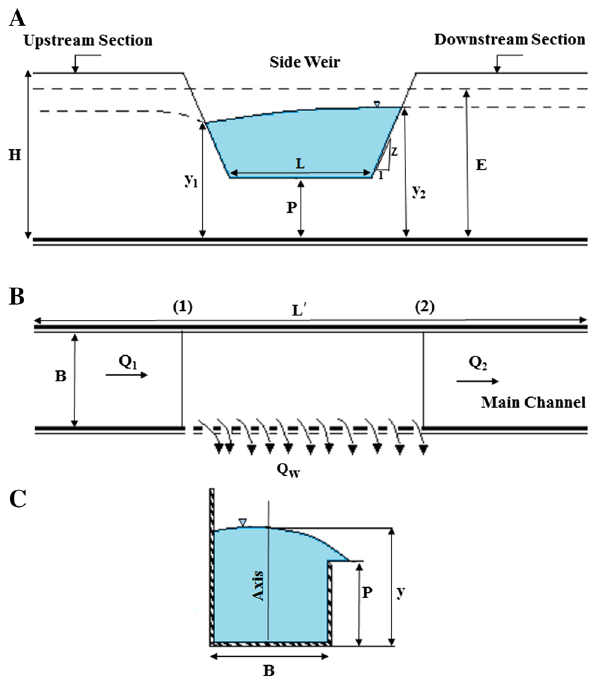
Fig. 1 General scheme of a TSCSW: ( a ) longitudinal section, ( b ) plan view and ( c ) cross-sectional